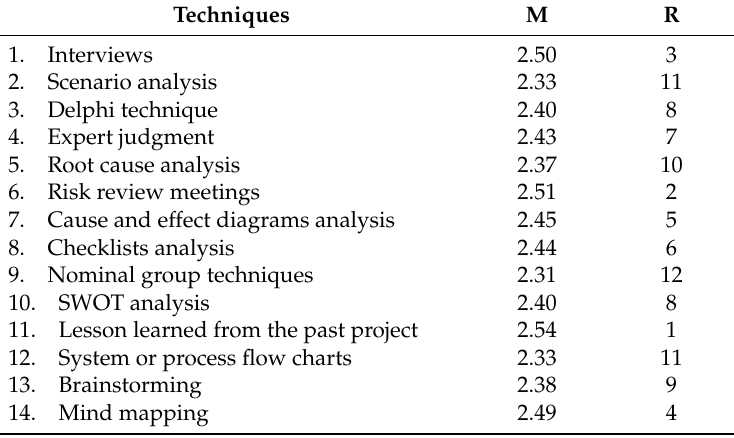
Table 3. Ranking of Risk Identification Techniques.